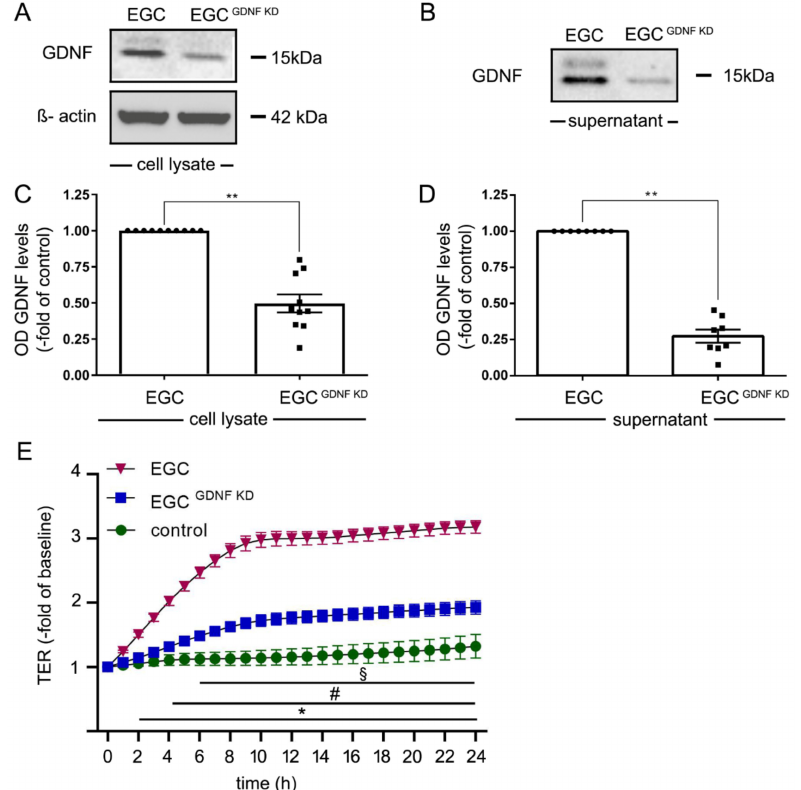
Figure 4. Knockdown of glial cell line-derived neurotrophic factor (GDNF) reduced effects of enteric glial cells (EGC) on barrier properties of Caco2 cells. ( A ). Representative Western blot of cell lysates of EGC to confirm reduced GDNF levels following knockdown of GDNF in EGC (EGC GDNF KD ); ( n = 10). ( B ). Representative Western blots of cell culture supernatants from EGCs and EGC GDNF KD to confirm reduced secretion of EGCs into cell culture supernatants; ( n = 8). ( C ). Quantifications of Western blots following knockdown of GDNF showed reduced levels to 45 ± 19% of control EGCs correlated to β -actin; ( n = 10, ** = p < 0.01, Wilcoxon signed-ranked test). Control = EGC WT. ( D ). Quantifications of Western blots from supernatants from EGC supernatants compared to EGC GDNF KD demonstrated reduced GDNF levels of 27 ± 12%; ( n = 8, ** = p < 0.01, Wilcoxon signed-ranked test). Control = EGC WT. ( E ). Measurements of TER revealed that incubation of Caco2 with EGC supernatant significantly increased TER to 330% ± 16% after 24 h whereas incubation with supernatants from EGC GDNF KD resulted in a significantly less pronounced increase of TER to 230% ± 18% (equates to 0.69-fold of EGC supernatants); ( n = 10 for each condition, § = p< 0.05 control vs. EGC, # = p < 0.05 EGC vs. EGC GDNF KD , * = p < 0.05 control EGC; two-way ANOVA); Control = Caco2 monolayer without